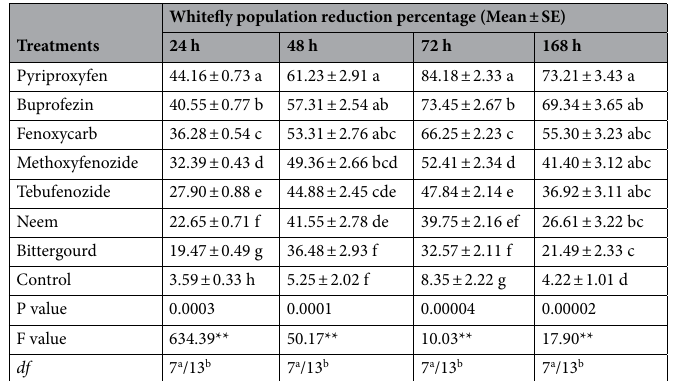
Table 1. Population reduction percentage of whitefly at different post-treatment intervals of different insecticides on Bt cotton under field conditions. Means with the same lowercase letters are not significantly different at α = 0.05 (Tukey’s test). df degree of freedom. a Degree of freedom of treatment. b Error degree of freedom. **Highly significant at probability level of 5%.